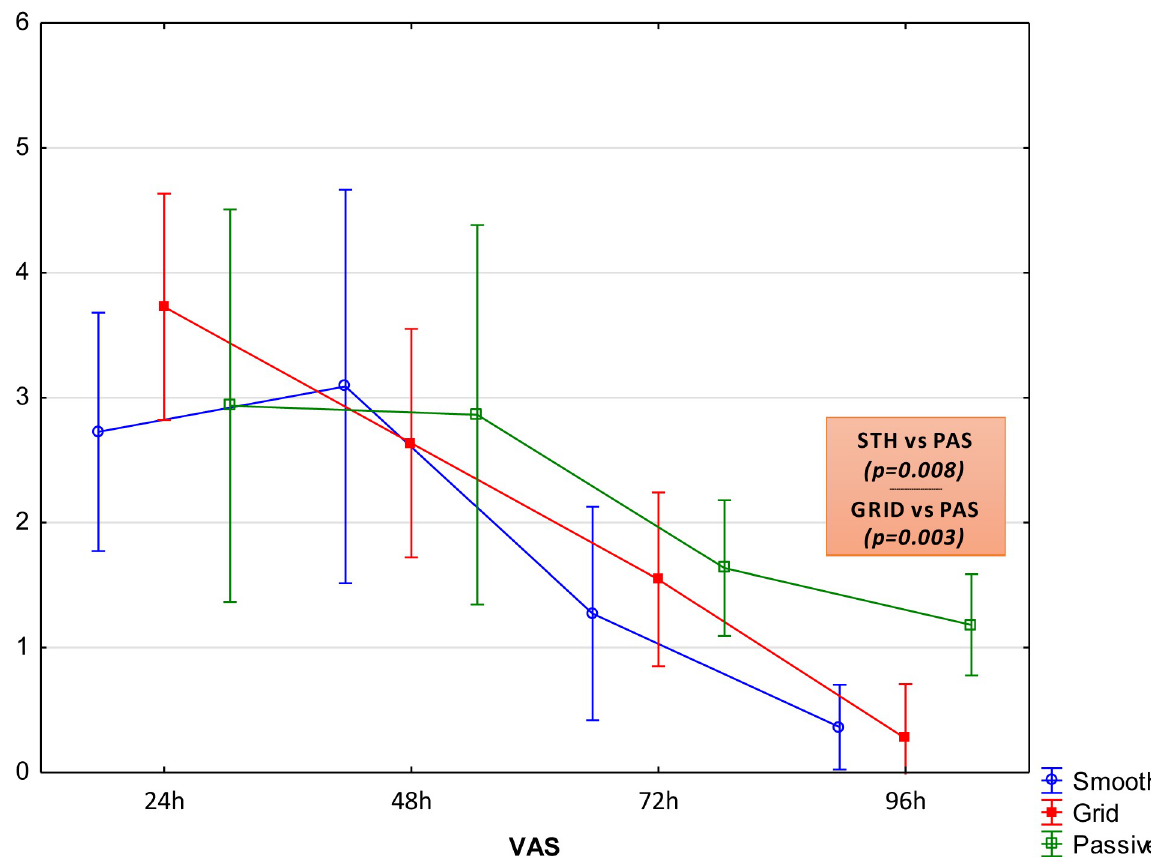
Fig 2. VAS values for the individual groups examined in subsequent measurements, mean values (95%